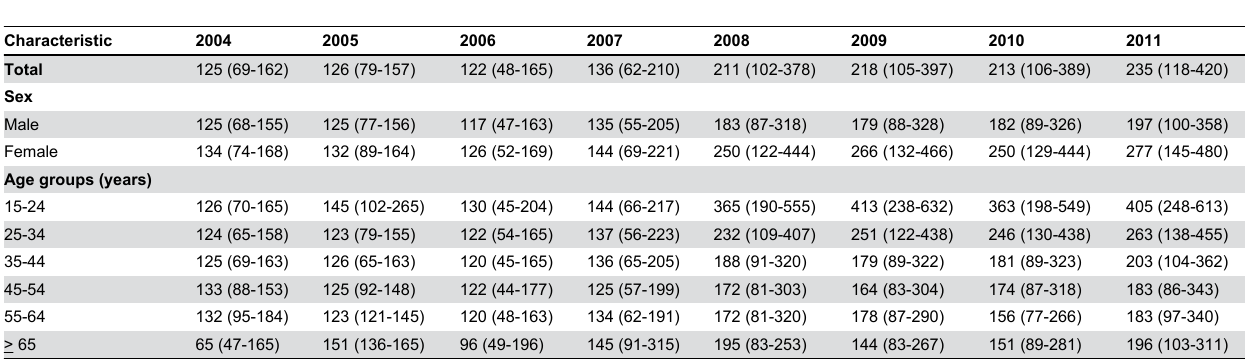
Table 2. Trends in median (interquartile range) baseline CD4 counts of newly diagnosed HIV-infected individuals registered for HIV care at antiretroviral therapy centres in Karnataka, India, 2004-2011.